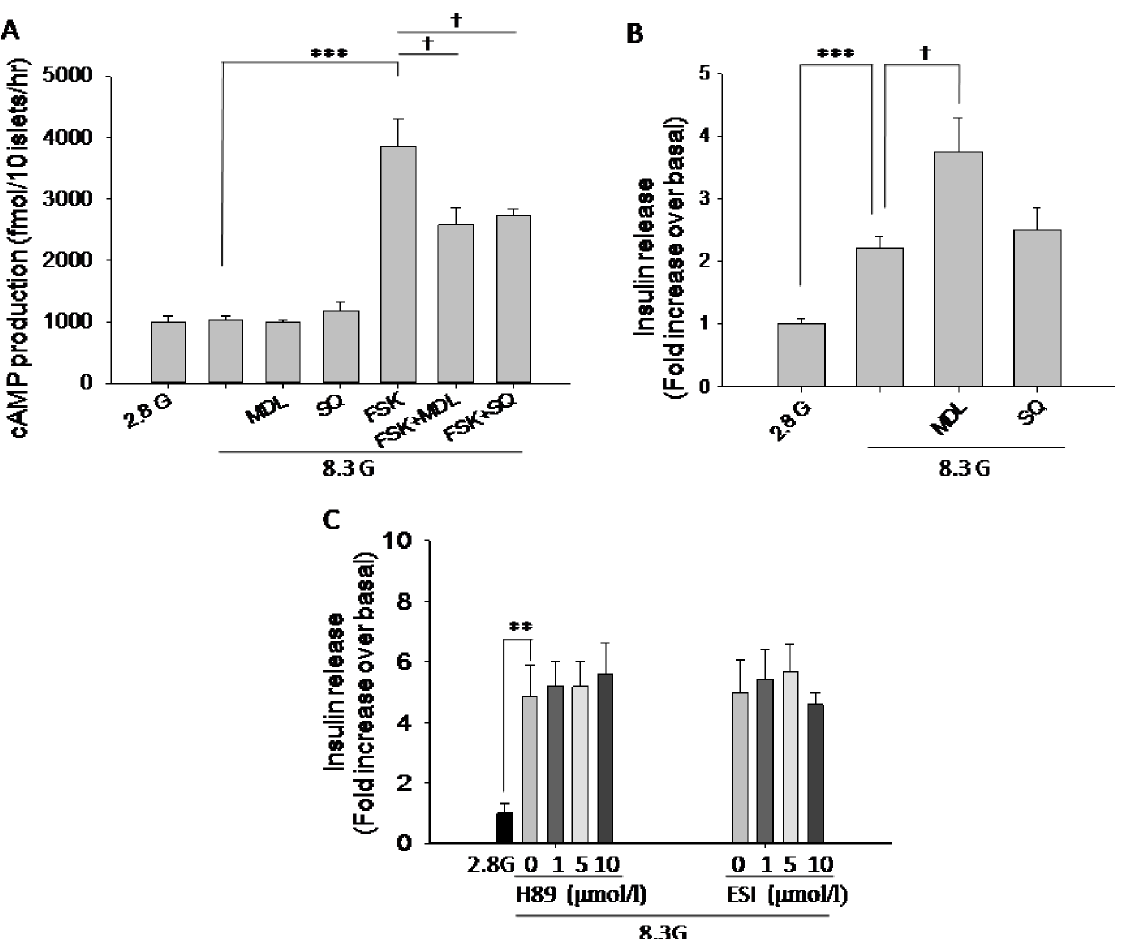
Figure 1. MDL-12,330A and SQ 22536 have similar effects on cAMP, but differ in insulin secretion. A. effects of MDL-12,330A (MDL, 10 m M, n=6) and SQ 22536 (SQ, 10 m M, n=6) on intracellular cAMP in the absence or presence of forskolin (FSK, 10 m M ) at 2.8 mM glucose (2.8 G) or 8.3 mM glucose (8.3 G) conditions. B. effects of MDL-12,330A (10 m M, n=6) and SQ 22536 (10 m M, n=8) on insulin secretion at 8.3 mM glucose condition. C. effects of H89 (1 m M, n=8; 5 m M, n=7; 10 m M, n=8) and ESI-09 (ESI, 1 m M, n=6; 5 m M, n=6; 10 m M, n=5) on insulin secretion at 8.3 mM glucose condition. **P , 0.01, ***P , 0.001, { P , 0.05.